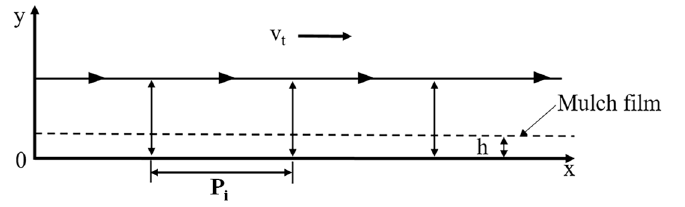
Figure 2. Ideal transplanting operations in plastic film ridge with minimal mulch film damage, where h is the dibbling depth and P i is the plant-to-plant distance after the transplanting operations.